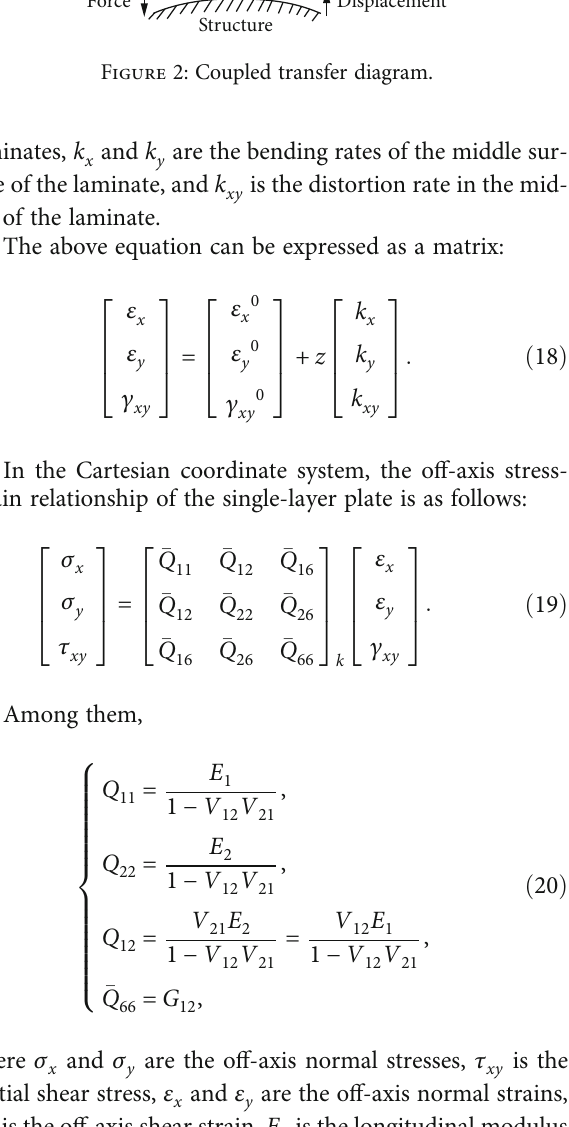
Figure 2: Coupled transfer